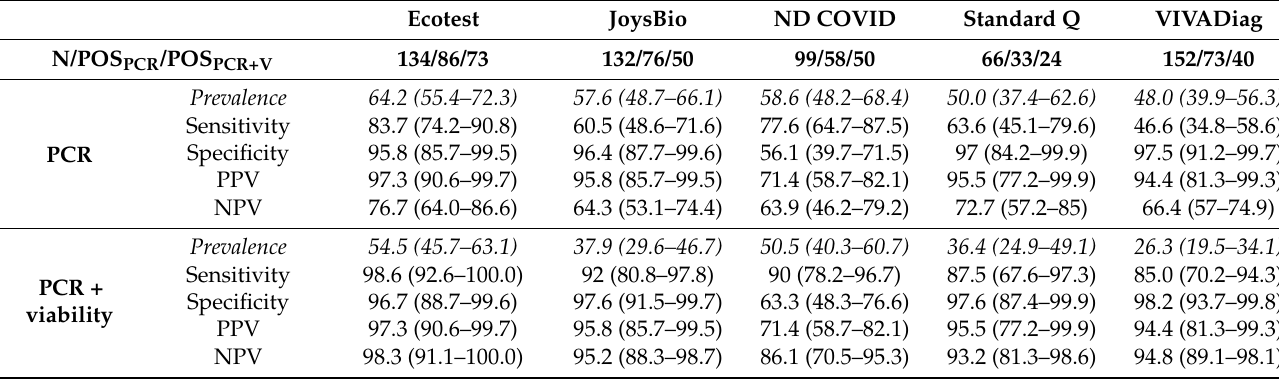
Table 4. Test parameters for individual ATGs for a subgroup of symptomatic patients (estimates and 95% confidence inter- vals).